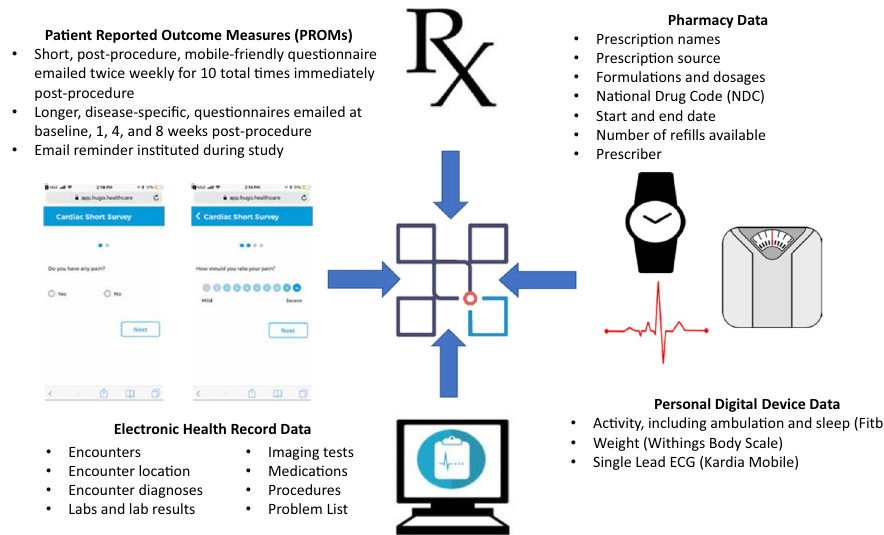
Fig. 9 Data aggregated using the Hugo platform. This fi gure demonstrates the 4 electronic health data sources aggregated in this study: patient reported outcome measures, electronic health record data, pharmacy data, and personal digital device